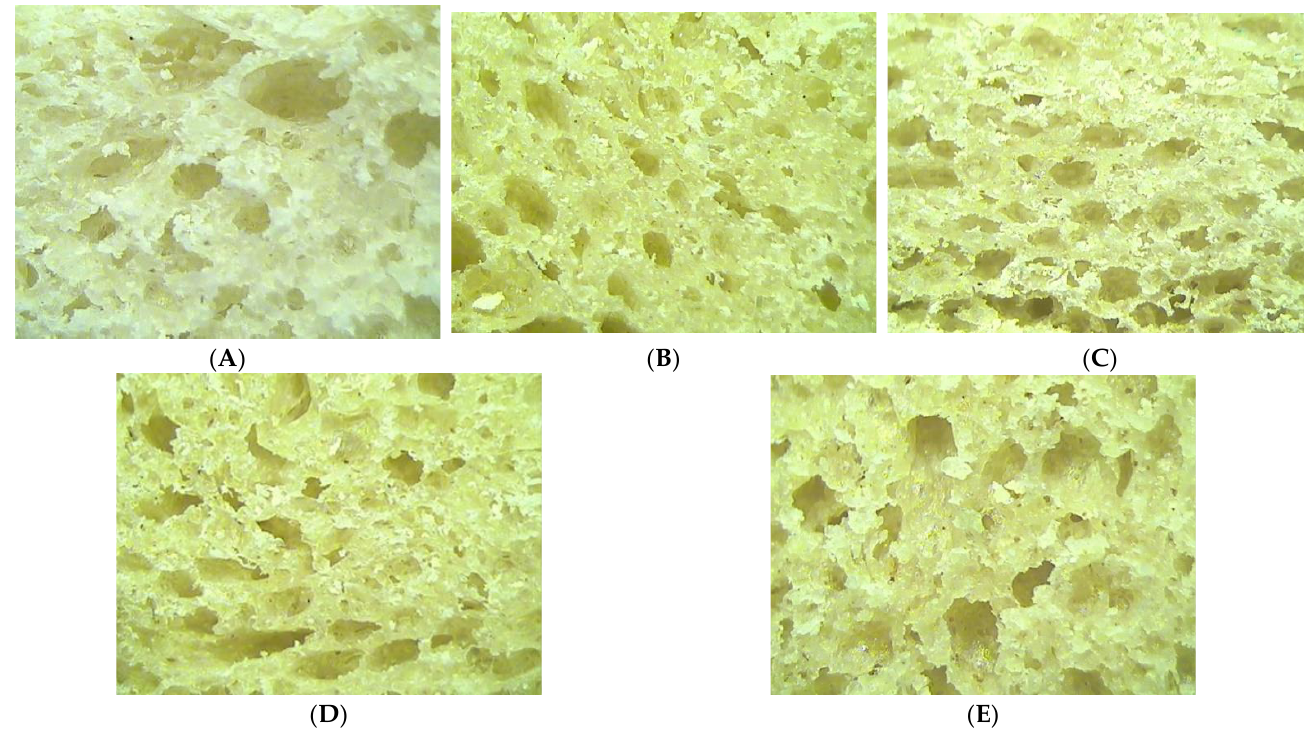
Figure 2. Structure of wheat dough with germinated lentil flour (LGF) at different levels: 0% ( A ); 2.5% ( B ); 5% ( C ); 7.5% ( D ); 10% ( E